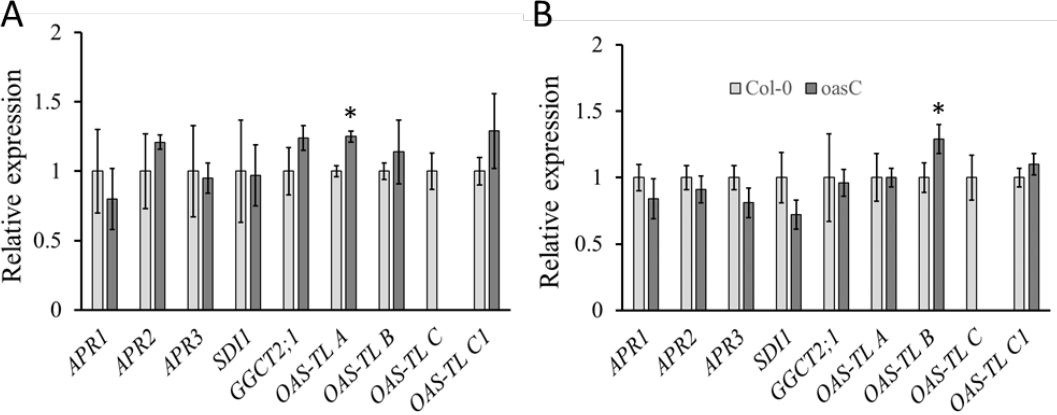
Figure 3. Disruption of OASC has no effect on expression of genes involved in sulfur metabolism. Col-0 (light grey) and oasC (dark grey) were grown for 2.5 weeks on MS-agarose plates. RNA was extracted from ( A ) shoots and ( B ) roots and relative transcript levels of nine genes involved in sulfur metabolism were analyzed by qPCR. The TIP4 gene was used as an internal control to normalize expression levels. Data are presented as means ± S.D. from four biological replicates analyzed in duplicates. Asterisks mark values significantly different from the wild-type Col-0 at p < 0.05 (Student’s t -test).